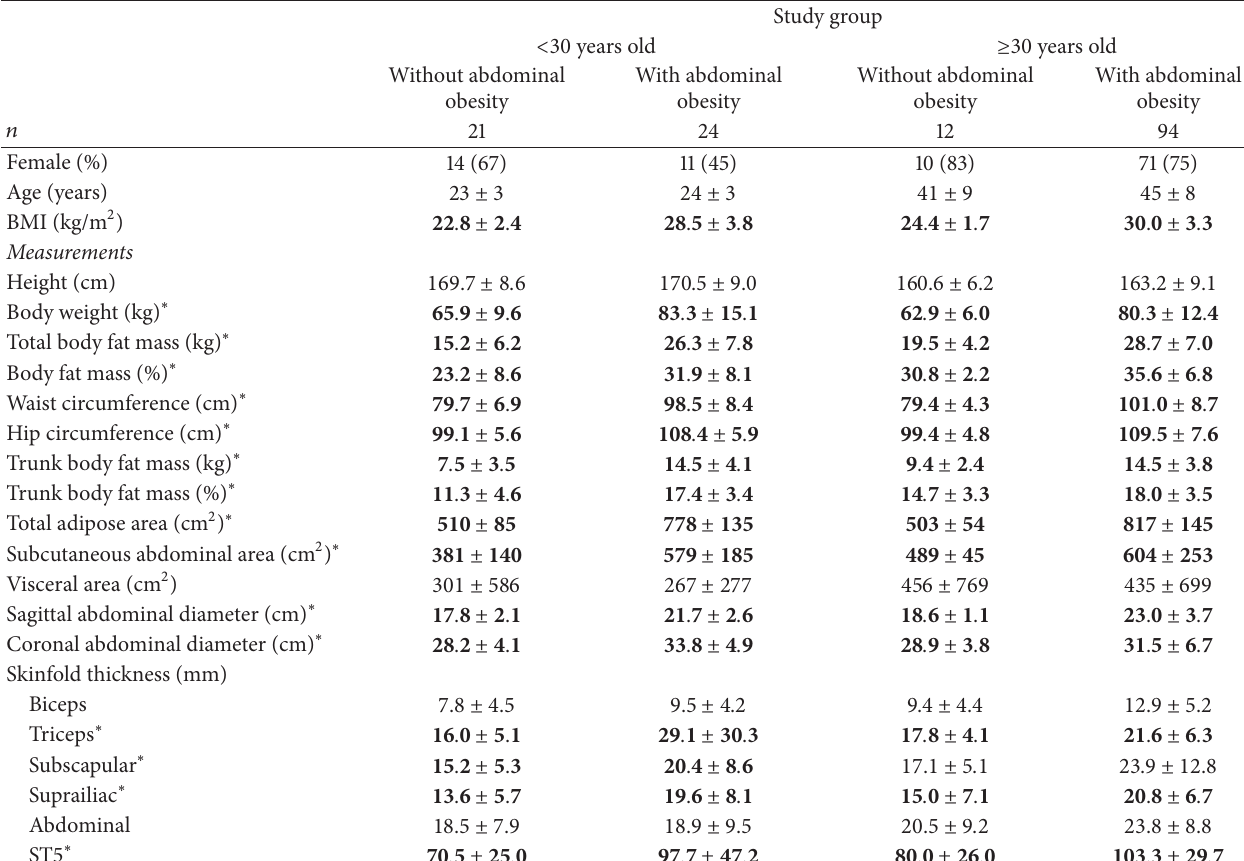
Table 1: Body dimensions and distribution of body fat storage according to age and abdominal